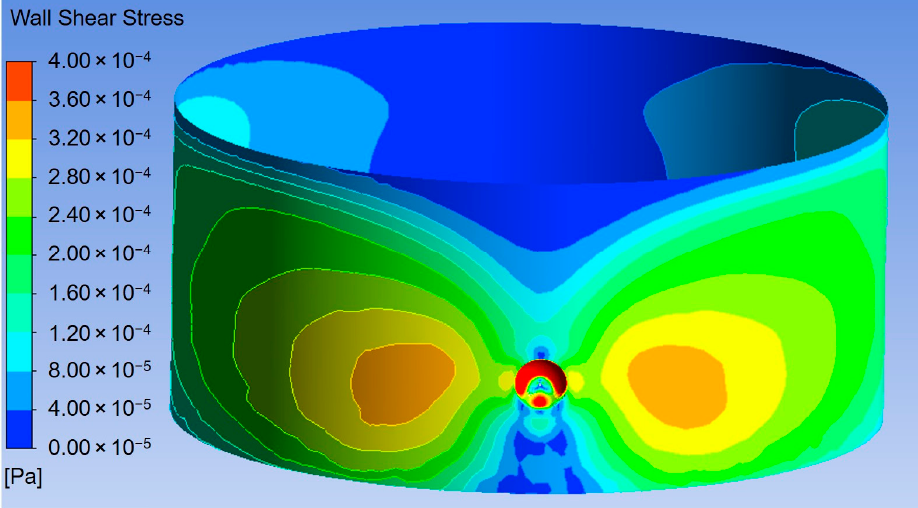
Figure 9. Shear-stress distributions on the inner-sidewall at a height of 1.5 m from the hearth bottom. ( a ) Original No. 1 BF case; ( b ) No. 7 Case.